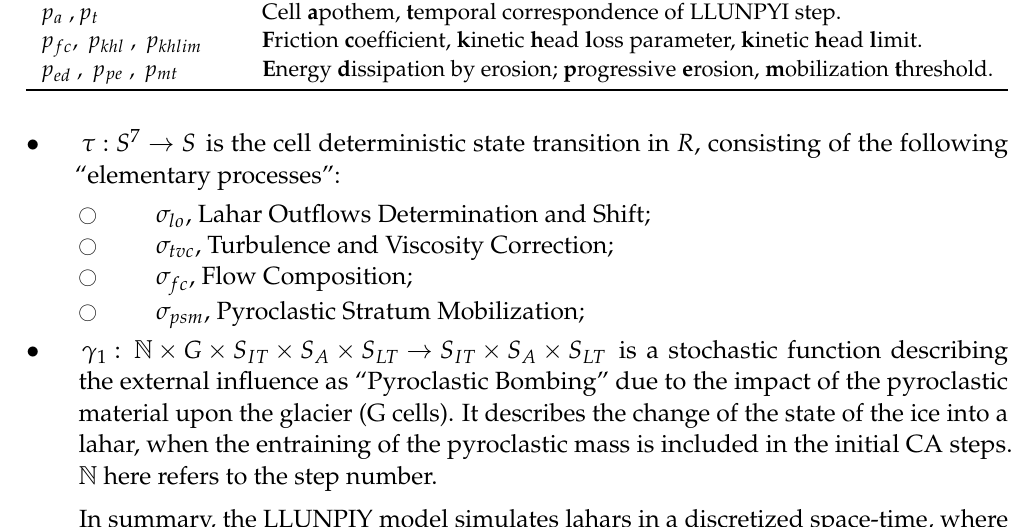
Table 2. Physical and empirical parameters.